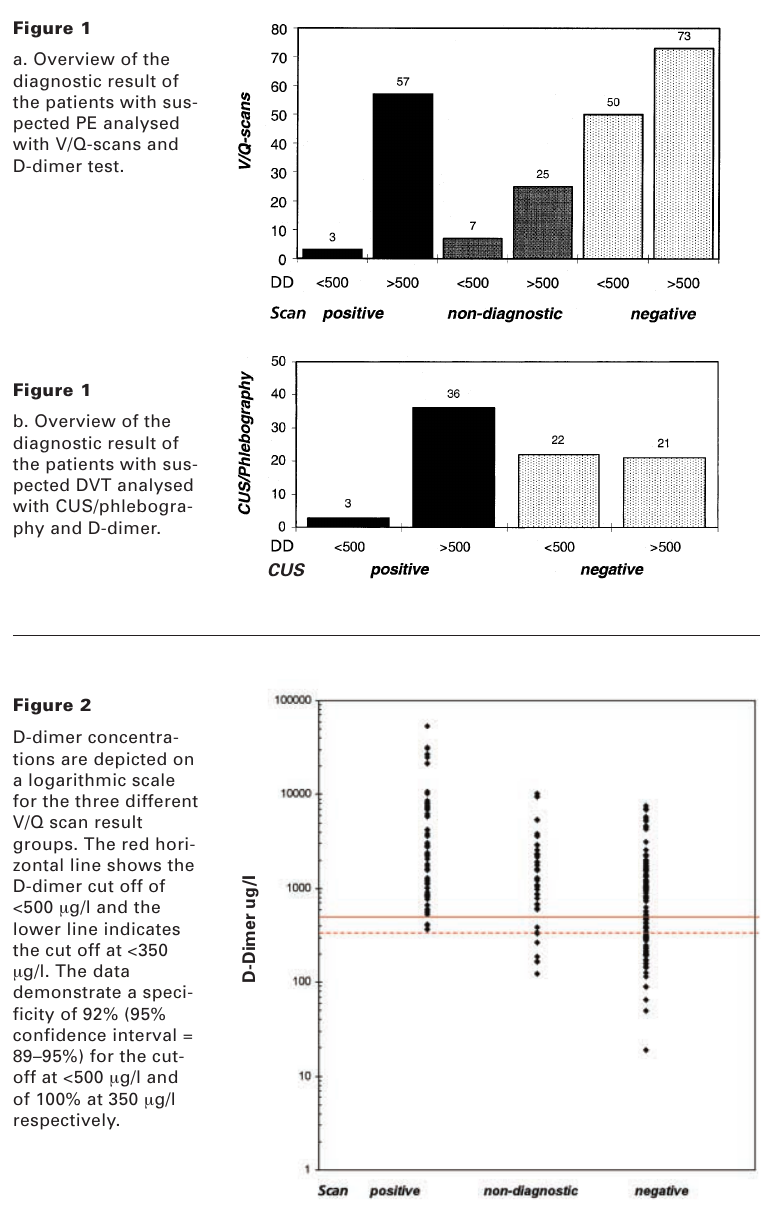
a. Overview of the diagnostic result of the patients with sus- pected PE analysed with V/Q-scans and D-dimer test.